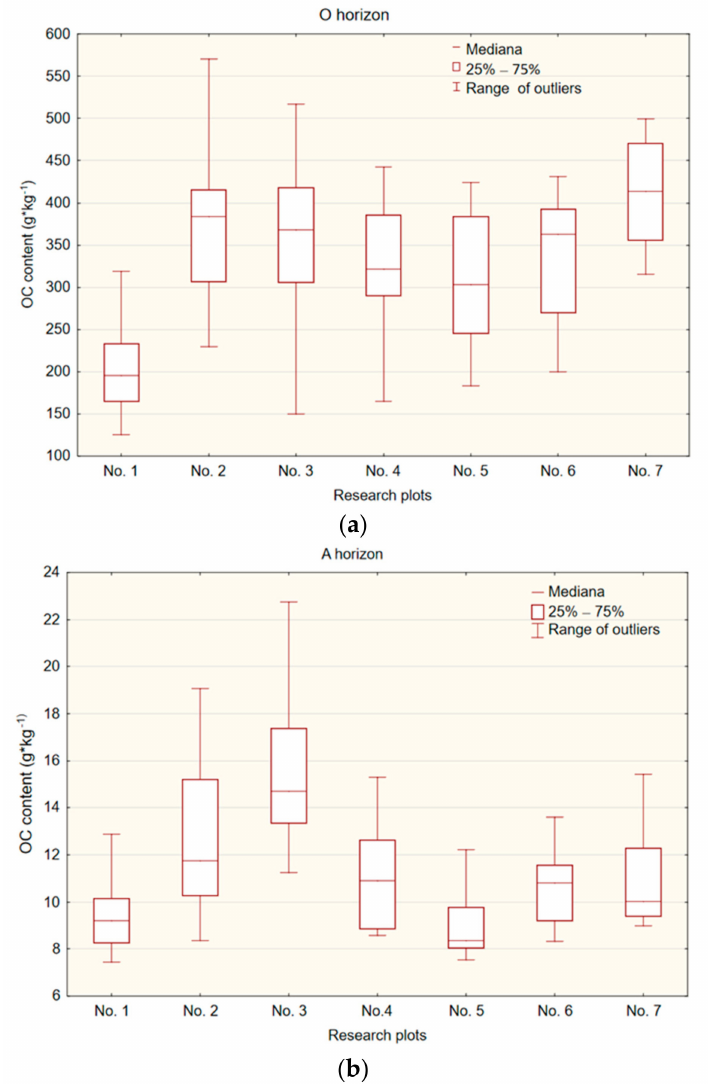
Figure 2. The distribution of the data of OC content in the topsoil horizons ( a ) O horizon; ( b ) A horizon. The Spearman’s correlation analysis ( p < 0.05) showed that the content of organic carbon in both A and O horizons were positively correlated with stand age (Table